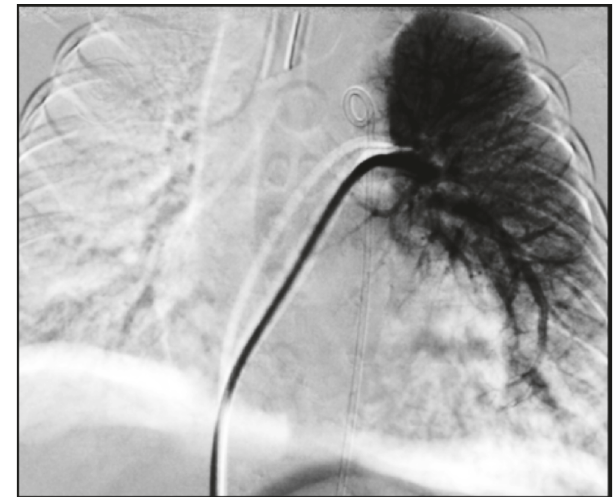
Figure 1: Aortic cineangiogram. Contrast into the descending aorta showsalargeaortopulmonarycollateralarisingfromthedescending aorta supplying the entire left lower lobe of the lung.